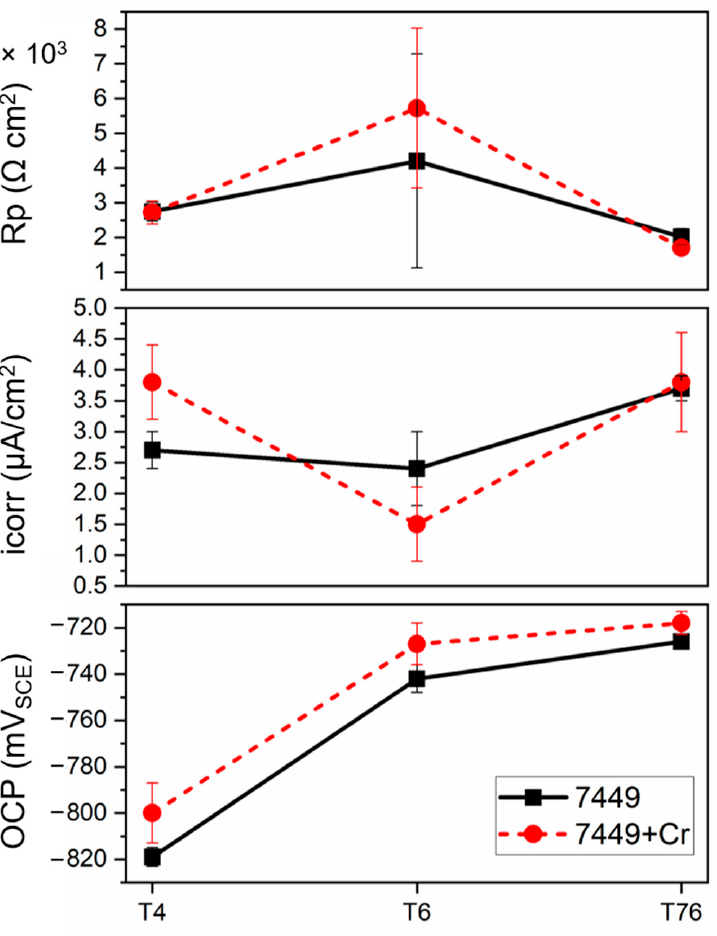
Figure 13. Measured electrochemical parameters from potentiodynamic polarization tests in different aging conditions .